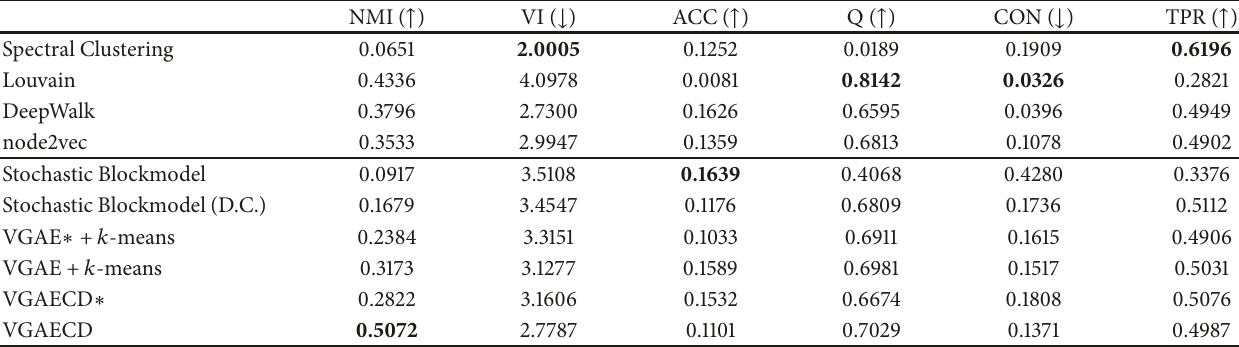
Table 4: Experimental results on Cora dataset.